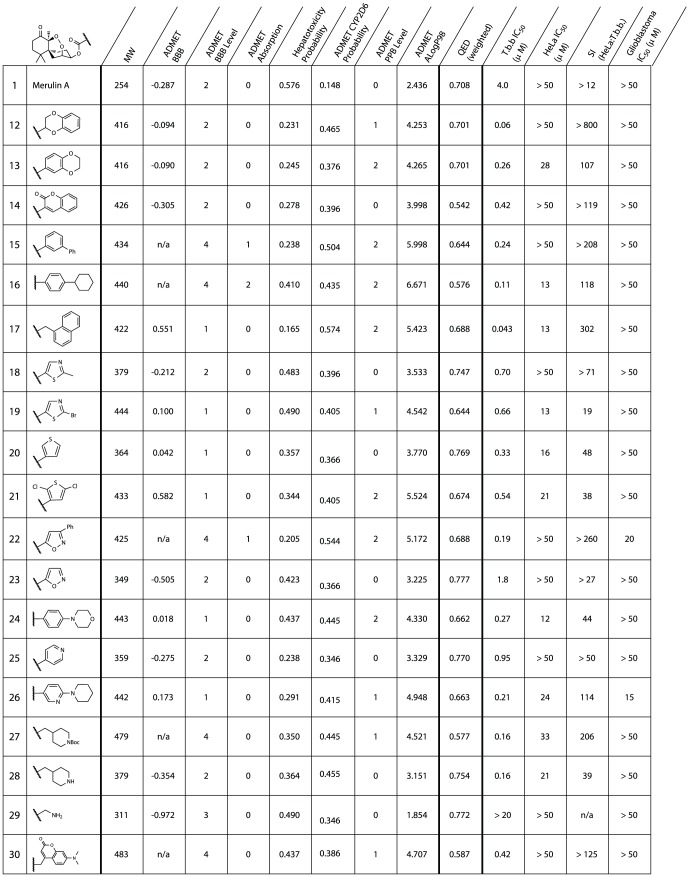
Ester library biological data.MW - Molecular weight; ADMET BBB – log of brain/blood partition coefficient; ADMET BBB Level – Ranking of the LogBB values into the following levels: 0 - Very high (value≥0.8), 1 – High (0.8>value≥0.0), 2 – Medium (0.0>value≥−0.8), 3 – Low (value<−0.8), 4 – Undefined; ADMET Hepatotoxicity Probability; ADMET PPB Level – plasma protein binding level: the lower the number the better; QED - quantitative estimate of drug-likeness: the bigger the number the more drug-like, weighted using QEDw,mo
[17]. n.d. = not determined.